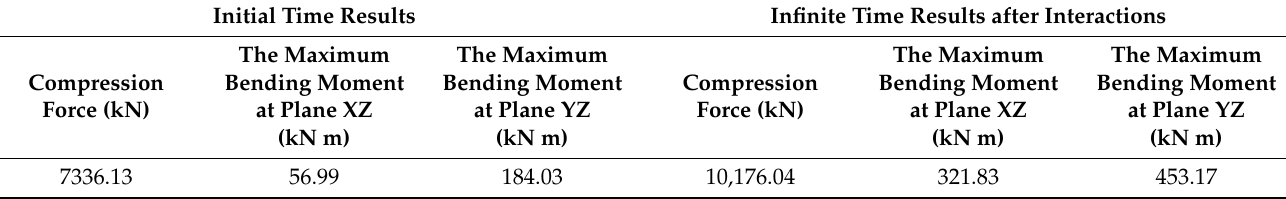
Table 5. Efforts at the first level of column